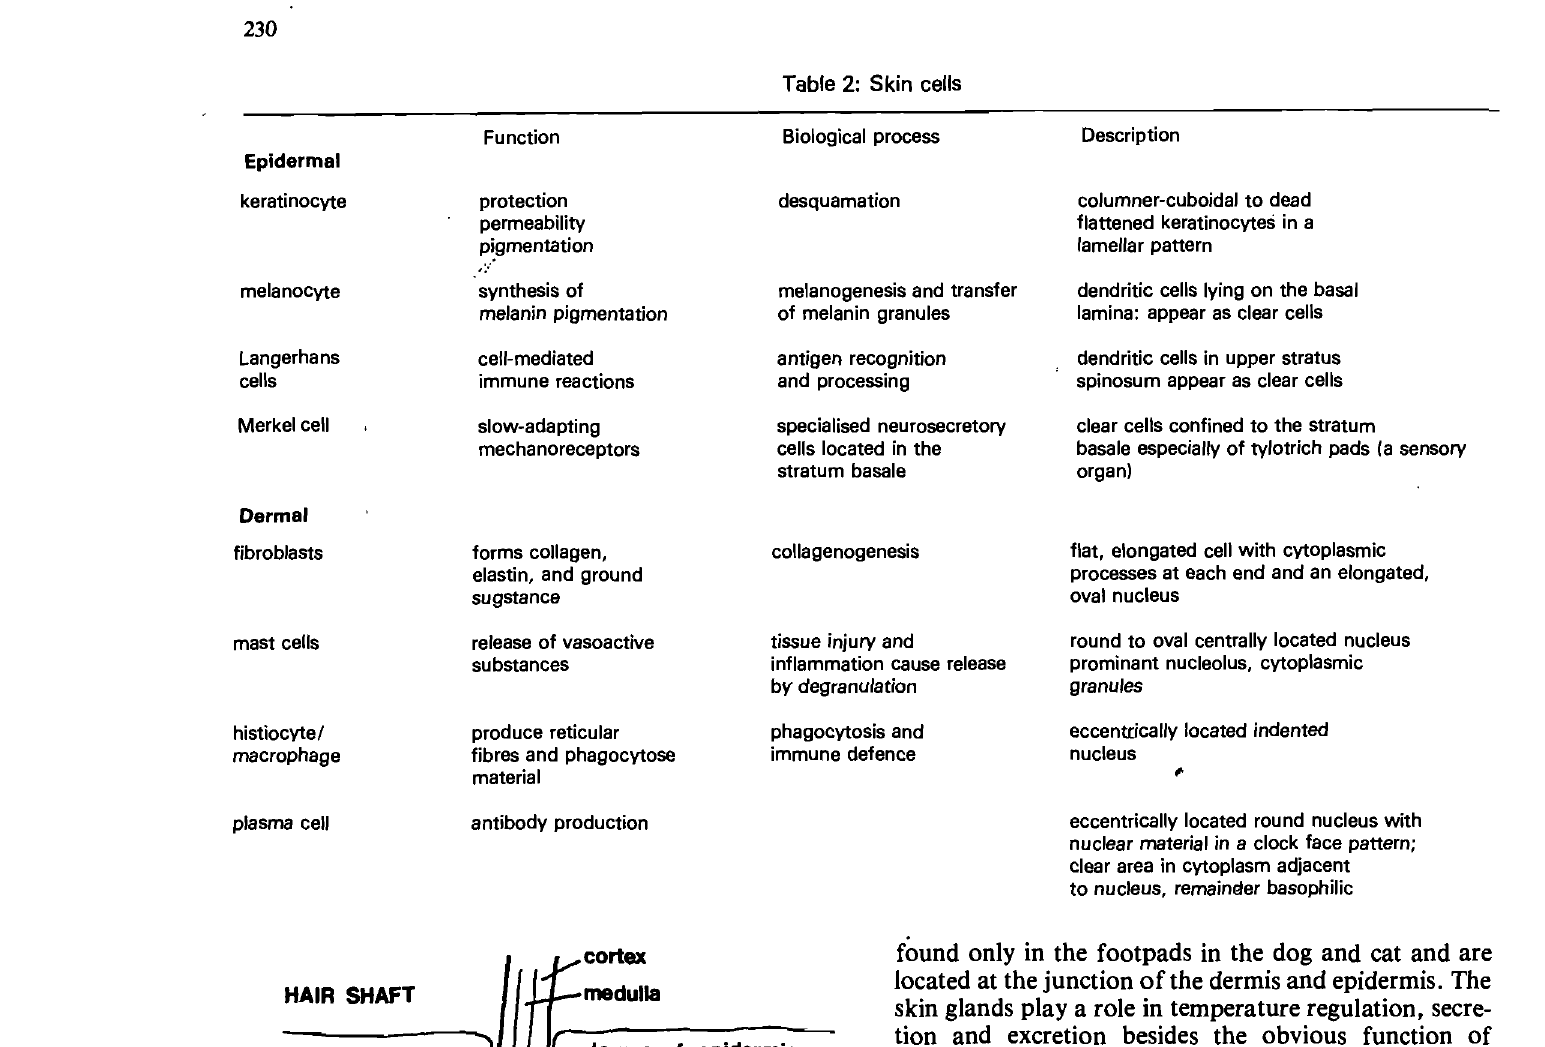
Fig. 1: The hair follicle unit consists of the hair follicle, its erector pili muscle, and apocrine and sebaceous glands. It is known as an "apopilosebaceous